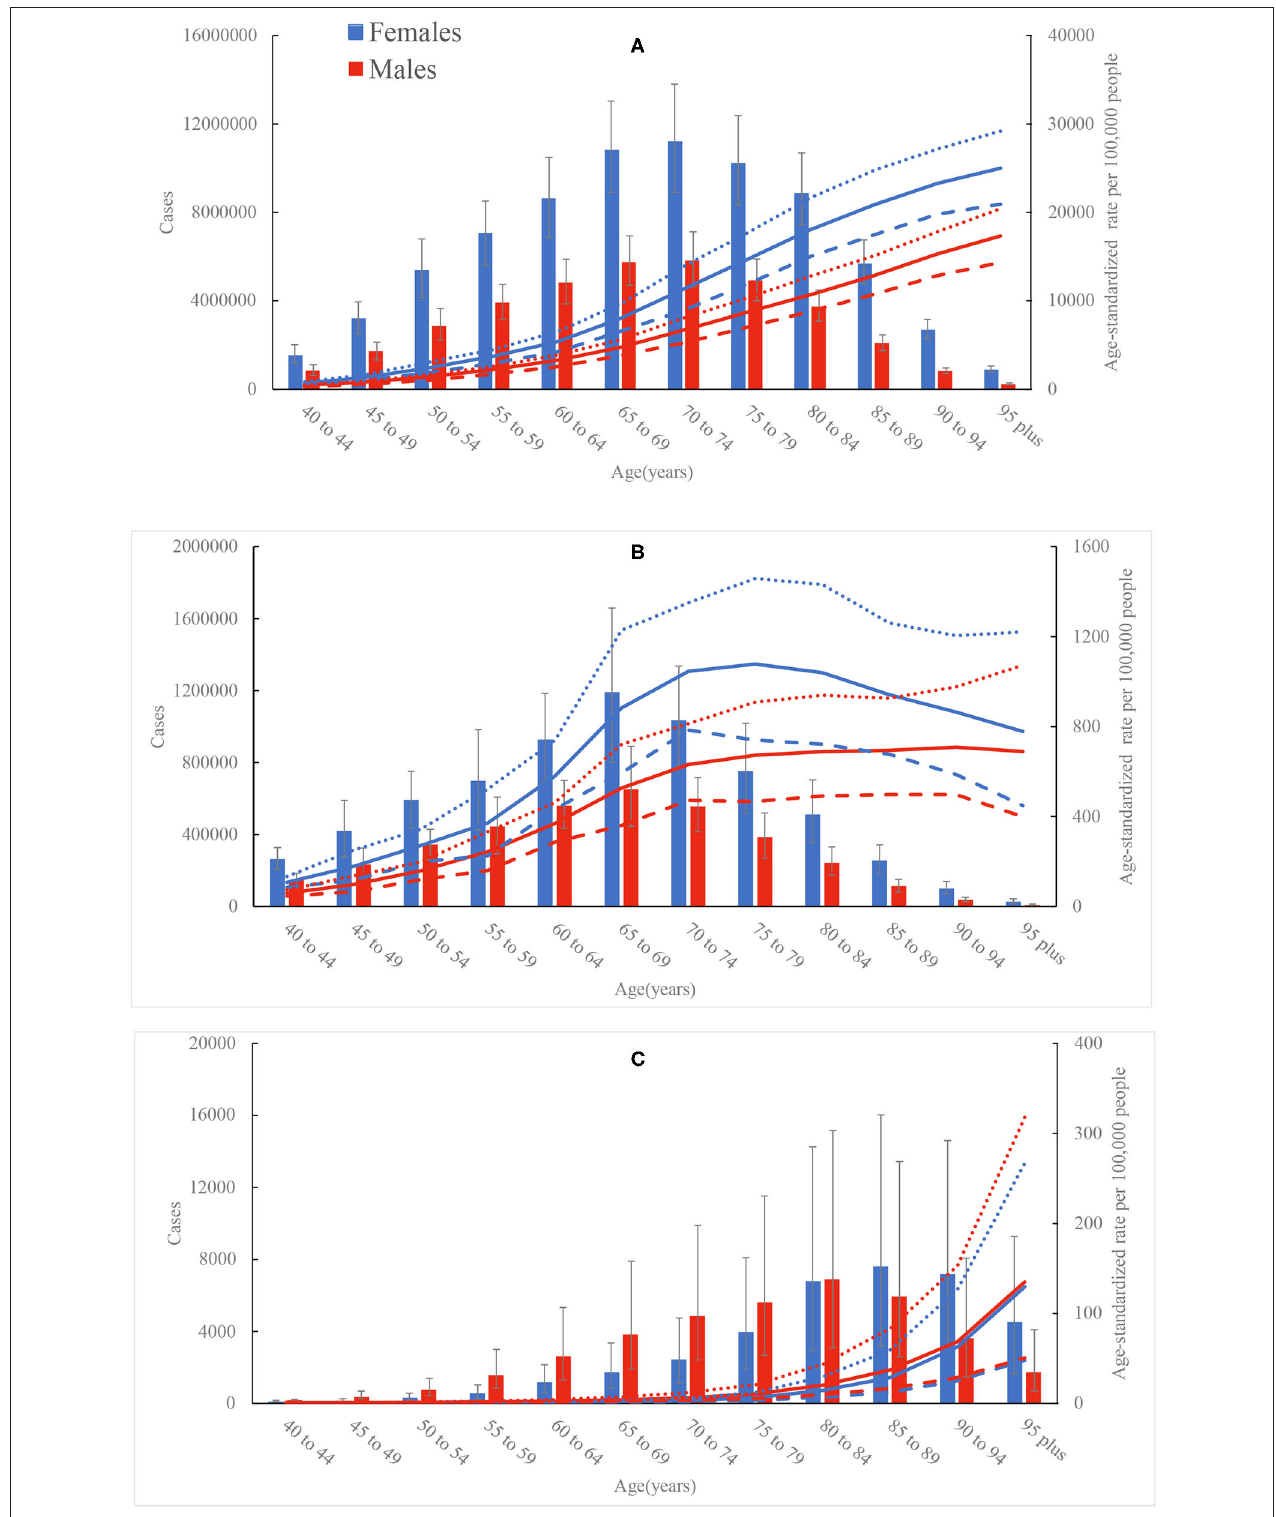
FIGURE 1 | Age-specific numbers and rates of prevalent cases (A) , incident cases (B) , and deaths (C) of peripheral artery disease by sex, 2019. Dotted and dashed lines indicate 95% upper and lower uncertainty intervals, respectively.